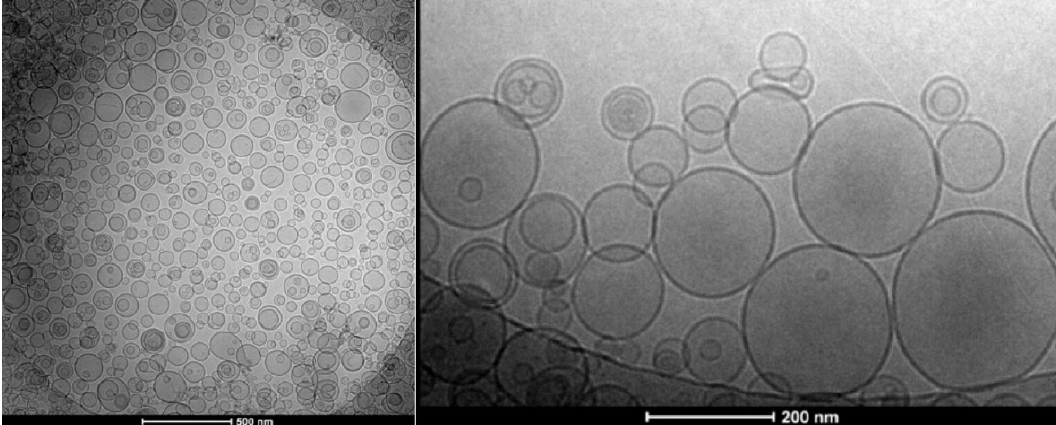
Figure 37. Applications of lipid vesicles for the delivery of food supplements. Cryo-TEM image of a soybean PC/“rape seed lecithin” vesicle dispersion containing entrapped vitamin C, as obtained by a simple procedure involving the use of glycerol and mechanical mixing steps, as published by Łukawski et al. (2020) [510]. Reproduced with permission from [510], Taylor & Francis,